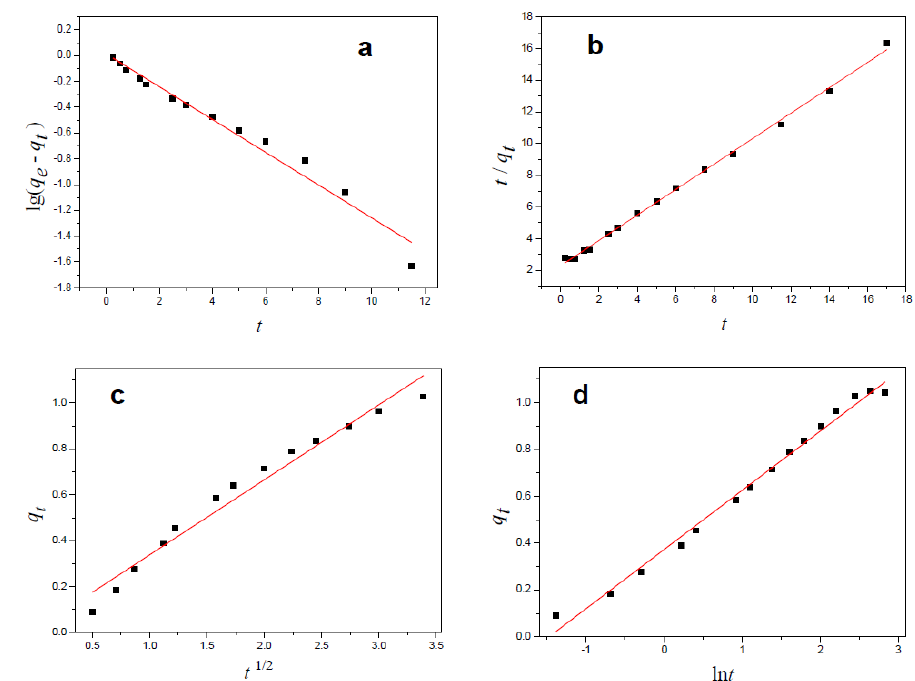
Figure 7. Effects of contact time ( a ) and initial concentration ( b ) on copper ion adsorption onto the hydrogel.